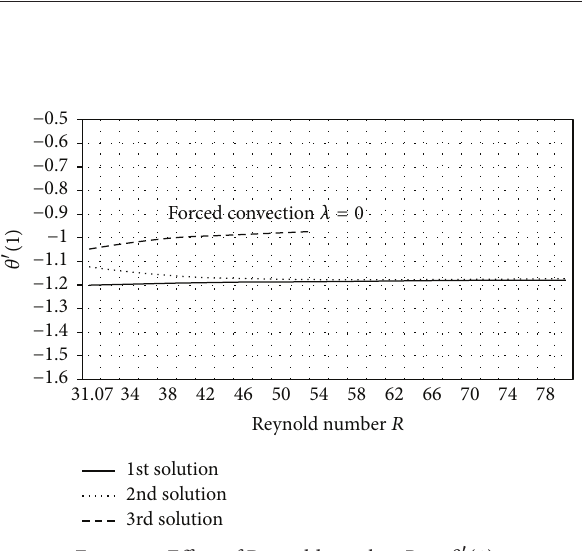
Figure 7: Effect of Reynold number 𝑅 on 𝜃 󸀠 (1) .